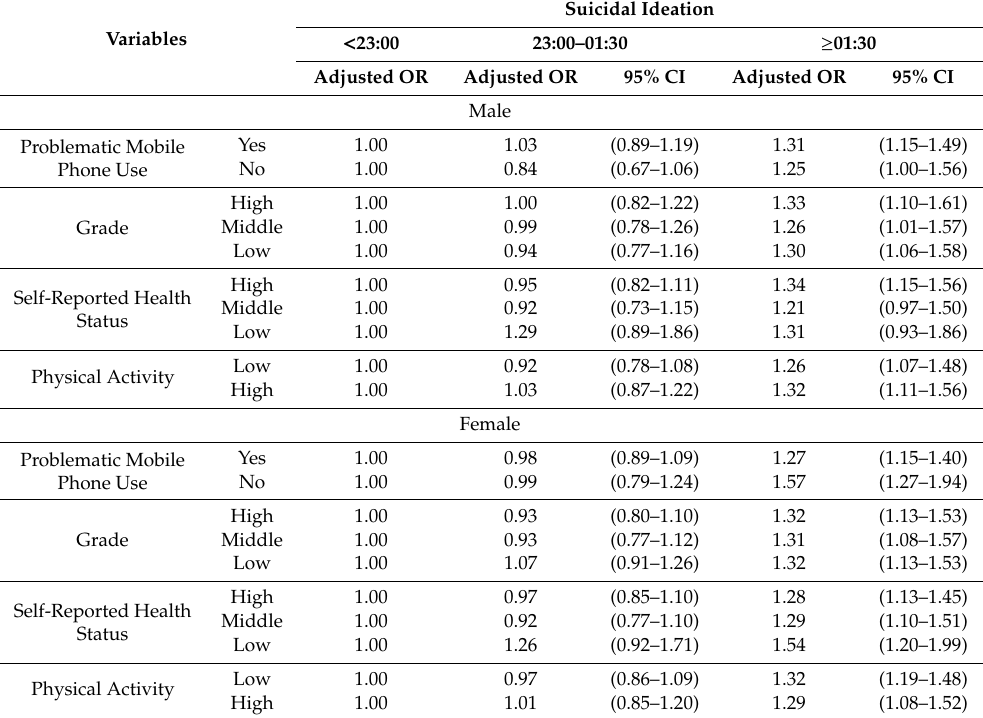
Table 2. Subgroup analysis of the association of bedtime with suicidal ideation stratified by covariates